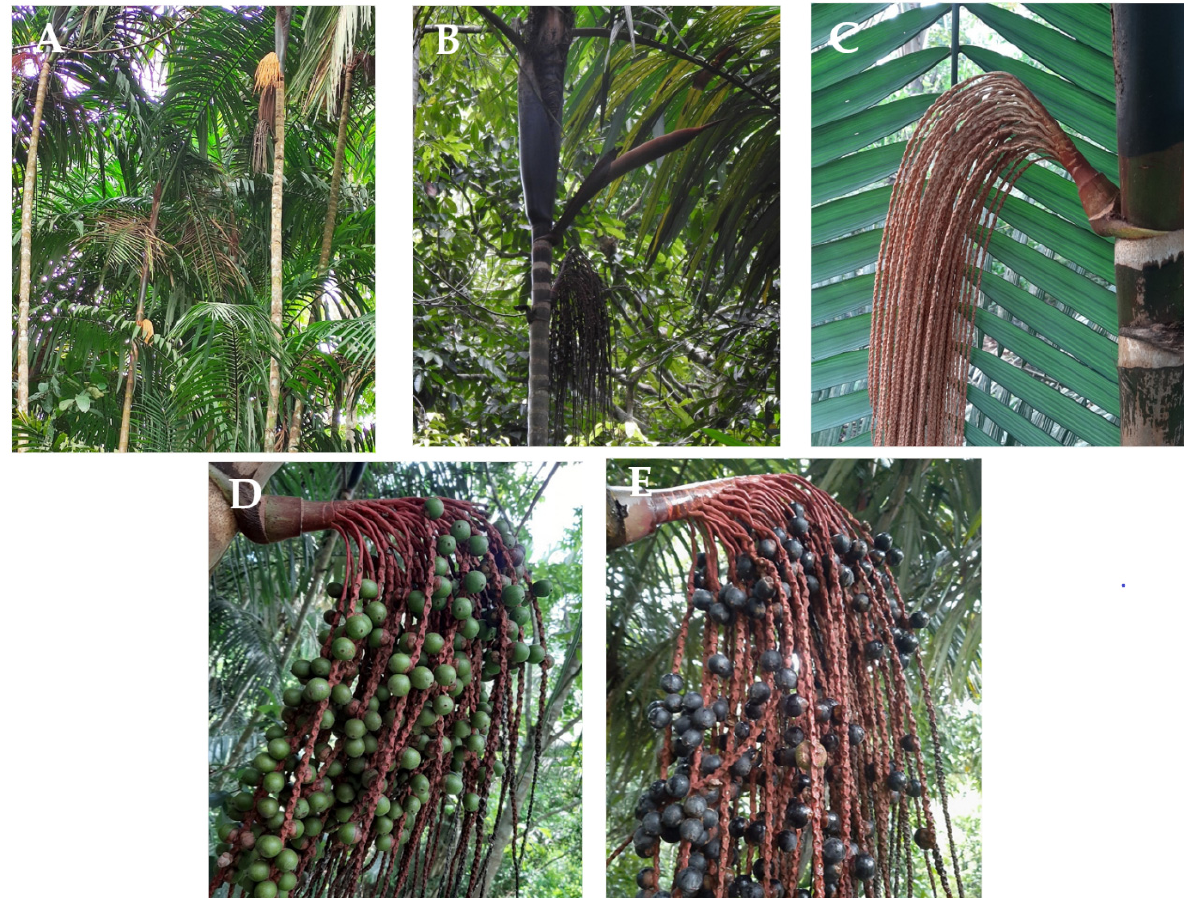
Figure 2. ( A ) O. mapora in its natural habitat, ( B ) Flower bud, ( C ) Open flower, ( D ) Unripe fruits and ( E ) Ripe fruits.